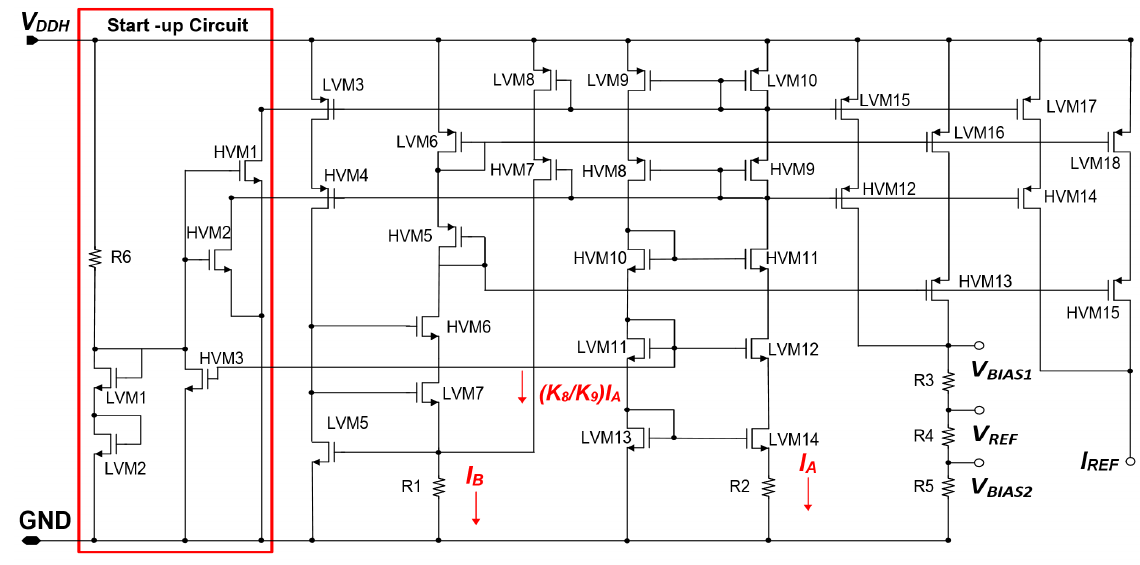
Circuit schematic of voltage and current reference generator with the startup